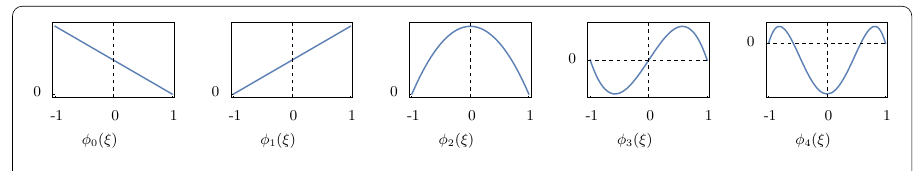
Fig. 3 Basis for one dimensional